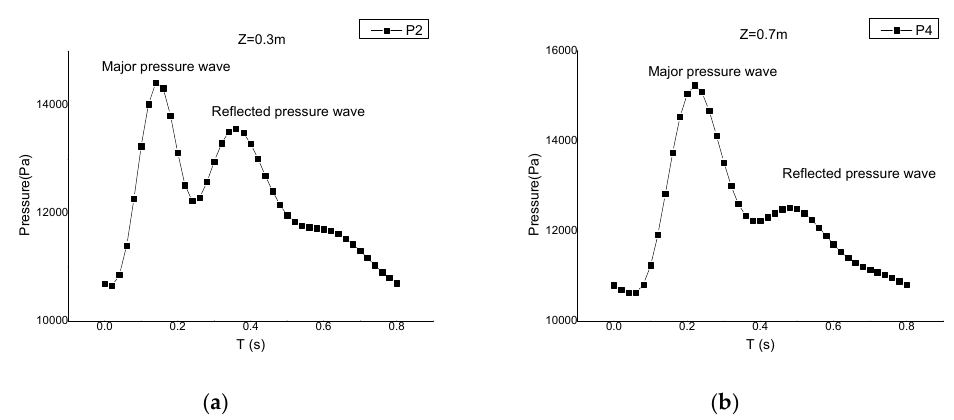
Figure 9. Pressure-time curves of measuring points: ( a ) P2 (0.3 m); ( b ) P4 (0.7 m).